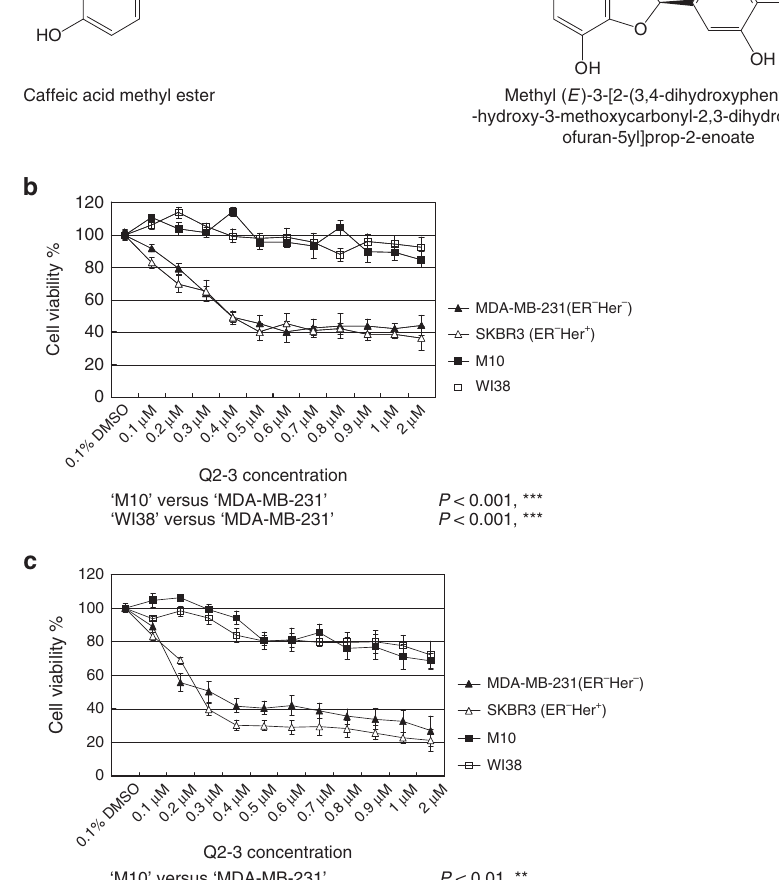
Figure 1 | Dihydrobenzofuran lignan (Q2-3) exhibits a specific cytotoxic effect on breast tumour cells. ( a ) Chemical reaction formula for synthesis of Q2-3 compound (methyl ( E )-3-[2-(3,4-dihydroxyphenyl)-7-hydroxy-3-methoxycarbonyl-2,3-dihydro-1-benzofuran-5yl]prop-2-enoate) from two caffeic acid methyl ester molecules. ( b , c ) MTTassays for cytotoxic effect of Q2-3 on SKBR3 (ER (cid:2) Her þ human breast cancer cell line), MDA-MB-231 (ER (cid:2) Her (cid:2) human breast cancer cell line), M10 (human normal epithelial cell line) and WI38 (human lung fibroblast cell line). 2 (cid:3) 10 4 cells were seeded and compared for their growth activity after treatment with Q2-3 for 24 or 72h. The beginning cytotoxic dosage of Q2-3 was detected at 0.3 m M, with 4 50% kill rate on SKBR3 and MDA-MB-231 cells. Data are reported as mean ± s.d. ( n ¼ 4). ** P o 0.01, *** P o 0.001 (Two-tailed t -test). Similar results were obtained